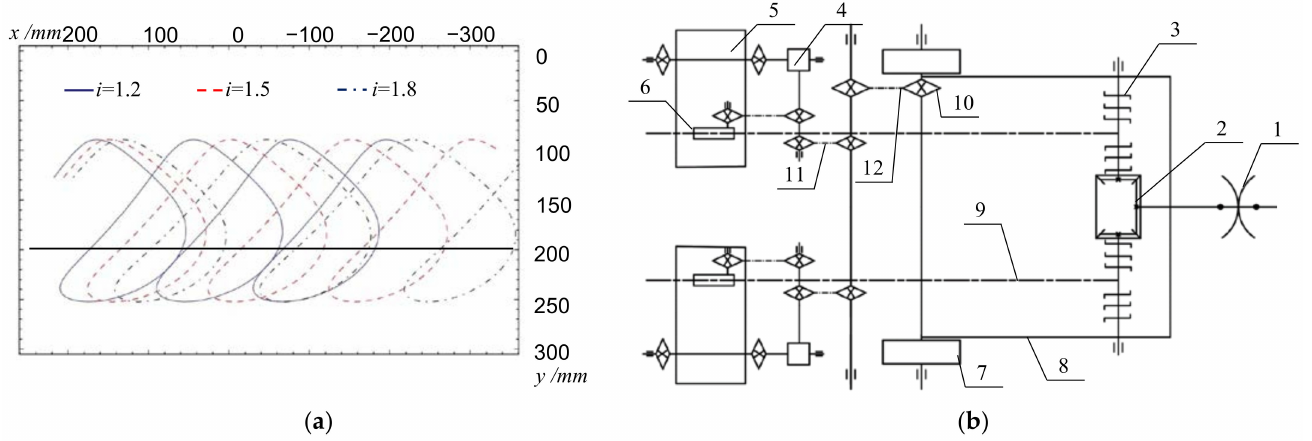
Figure 11. Transmission design of the slip transplanting apparatus. ( a ) The planting trajectory of the slip transplanting apparatus during operation. ( b ) Transmission path. Note: 1, Cardon joint; 2, Gearbox; 3, Rotary blade group; 4, Commutator; 5, Slip delivery mechanism; 6, Slip taking-planting mechanism; 7, Ground wheel; 8, Frame; 9, Middle line of the ridge; 10, Sprocket; 11, Chain drive; 12, Adjustable primary chain